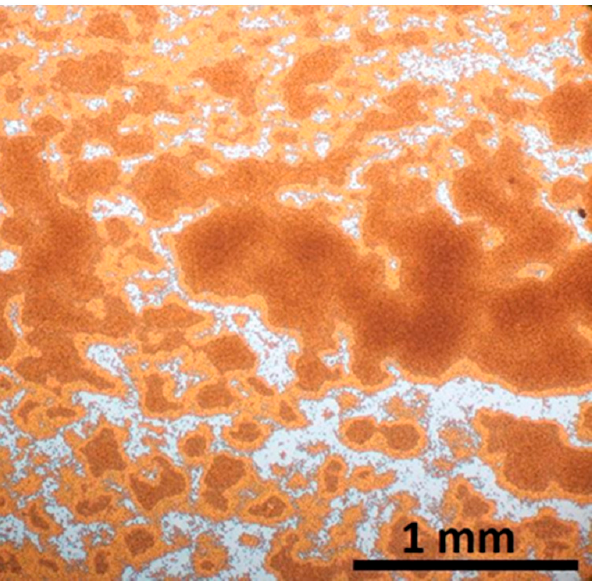
Figure 13. MSNs configurations obtained by drying in-situ application of a perpendicular magnetic field during spin-coating deposition of their aqueous solutions.